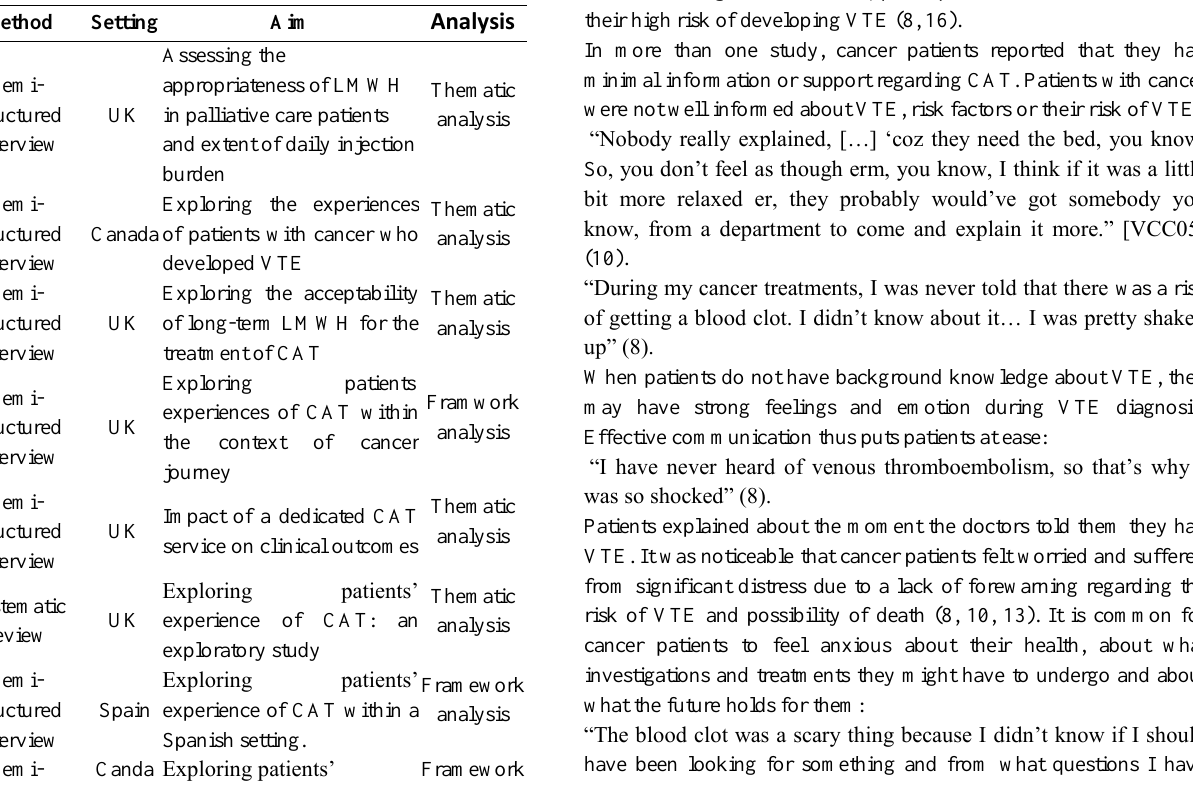
Qualitative studies of cancer-associated